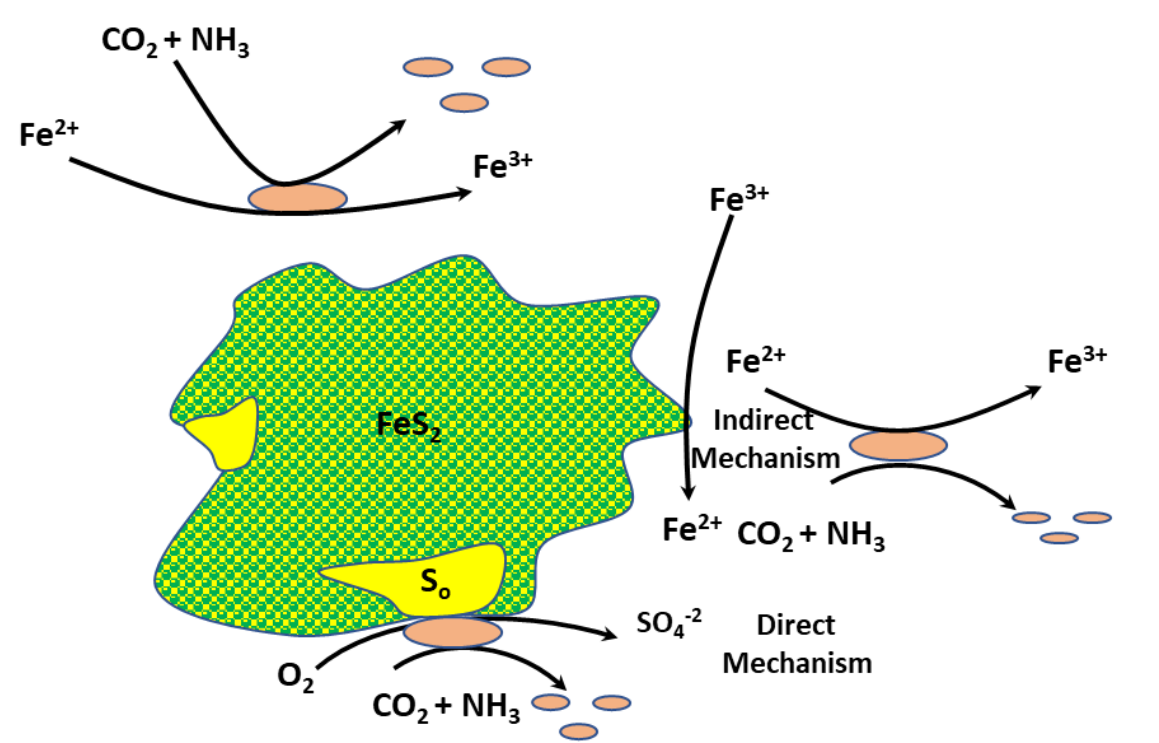
Figure 3. Schematic diagram of biooxidation of pyrite